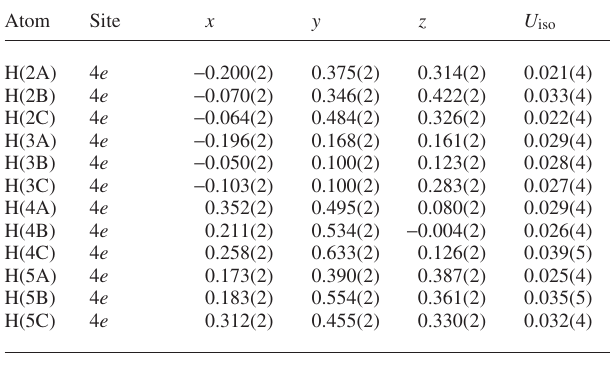
Table 2. Atomic coordinates and displacement parameters (in Å 2 ) .